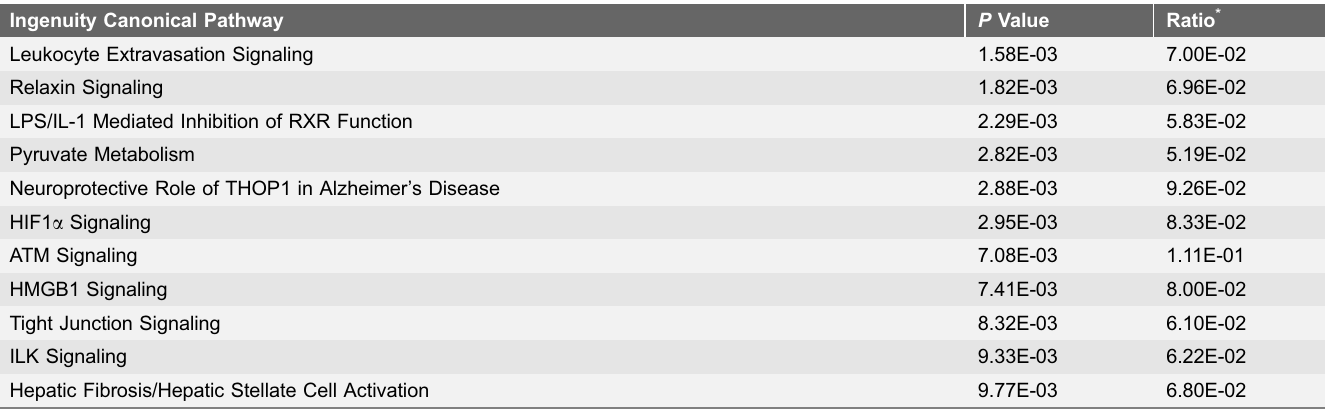
Table 4. The IPA pathways significantly associated with the differentially expressed transcripts in C. perfringens / E. maxima co-infected Ross chickens compared with uninfected controls. Ingenuity Canonical Pathway Leukocyte Extravasation